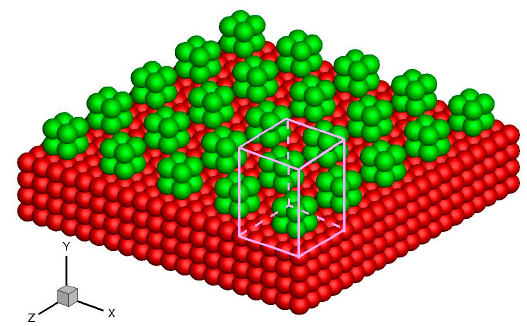
Figure 10. Schematics of the rough wall and unit cuboid domain above the wall surface. The red atoms are smooth wall atoms and the green atoms are roughness elements.